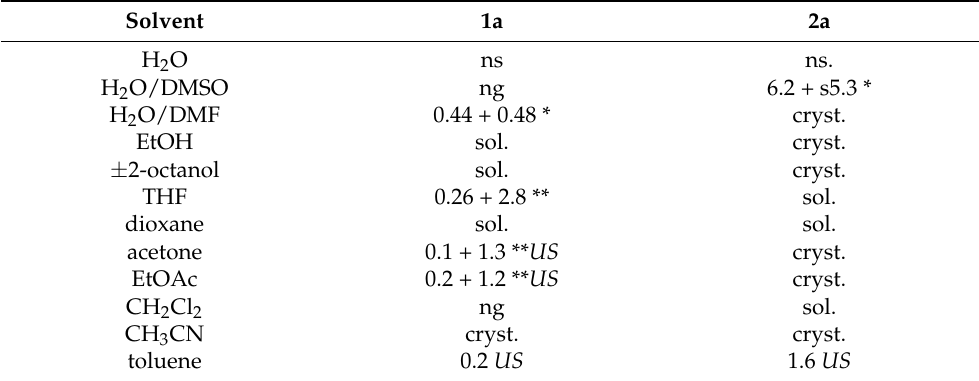
Table 1. Gelation efficiencies expressed as maximal volume ( ν max ) immobilized by 10 mg organogela-